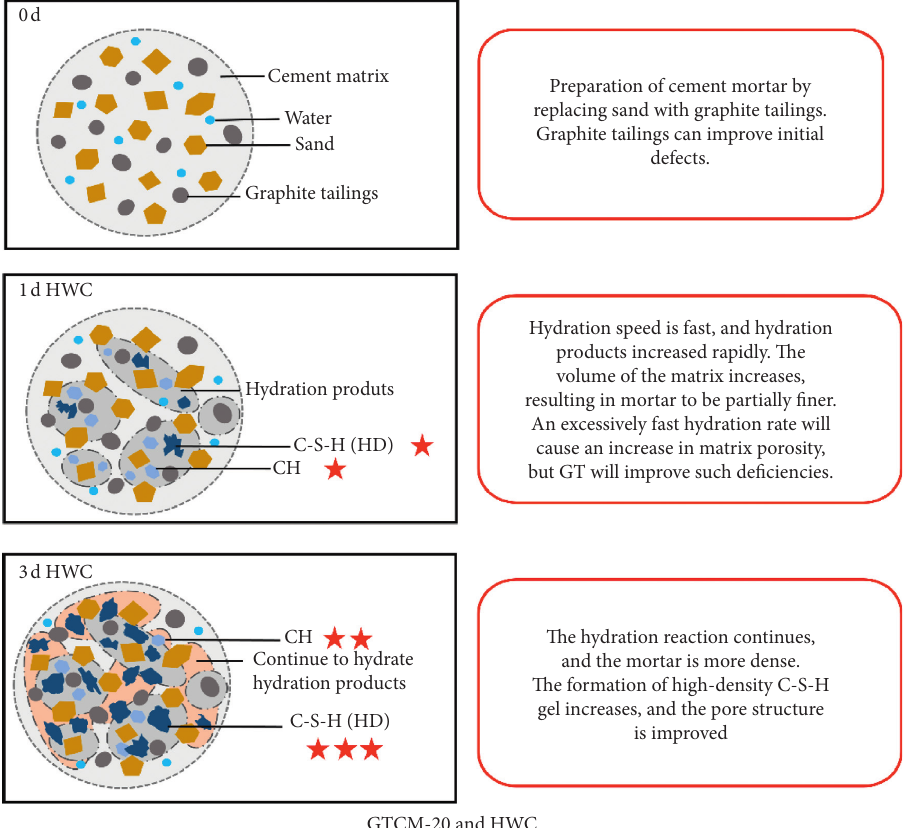
Figure 13: Combined effect mechanism diagram of the GT and HWC method on the early structure and performance of cement